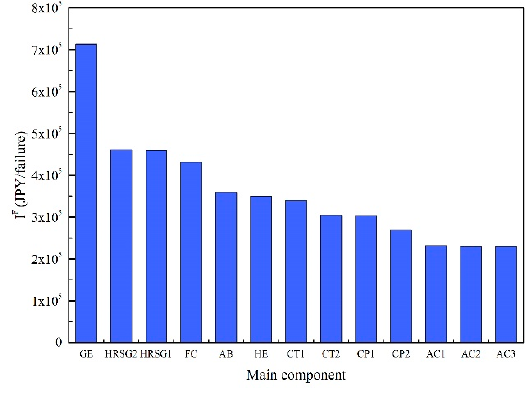
Figure 14. The failure cost importance index values of components of the CCHP system.